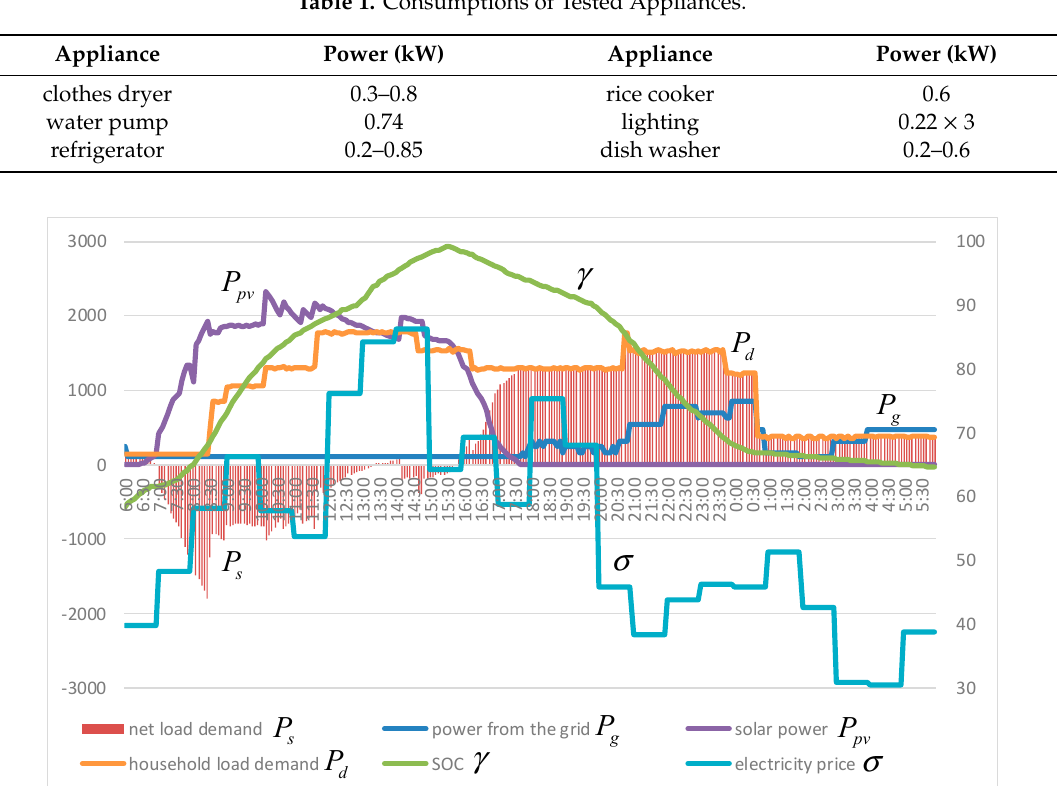
Figure 3. Output of fuzzy controller for the first scenario (sunny day). Table 1. Consumptions of Tested Appliances.